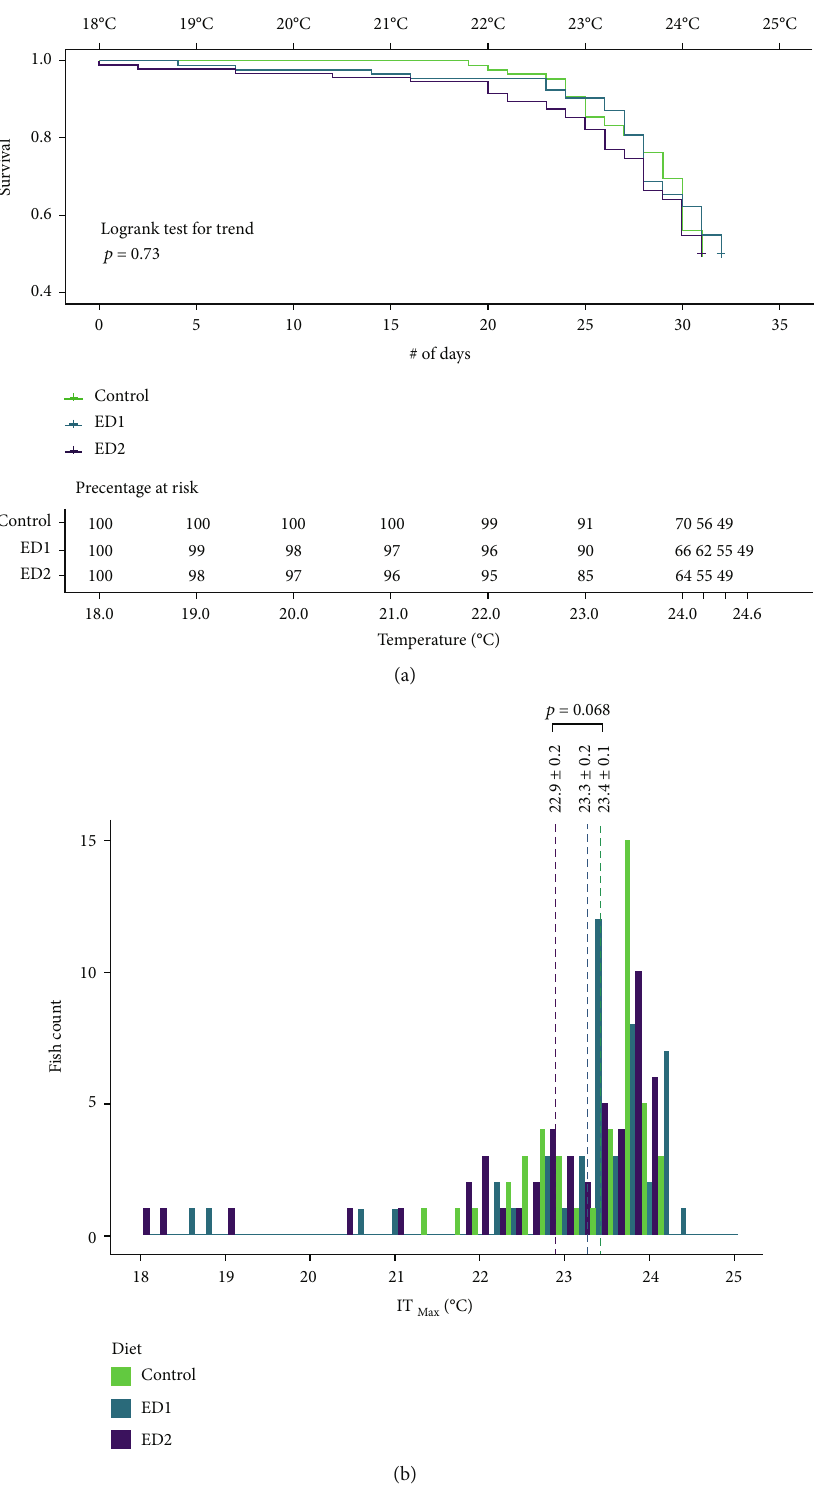
Figure 5: The incremental thermal maximum (IT at 50% mortality in each dietary treatment) of female triploid Atlantic salmon exposed Max to a temperature increase of 0.2 ° C day -1 from 18 ° C after prolonged exposure to elevated temperatures ( ≥ 16 ° C) for 65 days. Fish were fed a control diet, or one of two diets supplemented with cholesterol (ED1 and ED2). (a) Kaplan-Meier survival curves are shown along with the results of the log-rank test to determine signi fi cance. (b) Histogram of the same dataset. The dashed lines indicating the average IT for the fi rst 50% of fi sh that succumbed to high temperature for each dietary